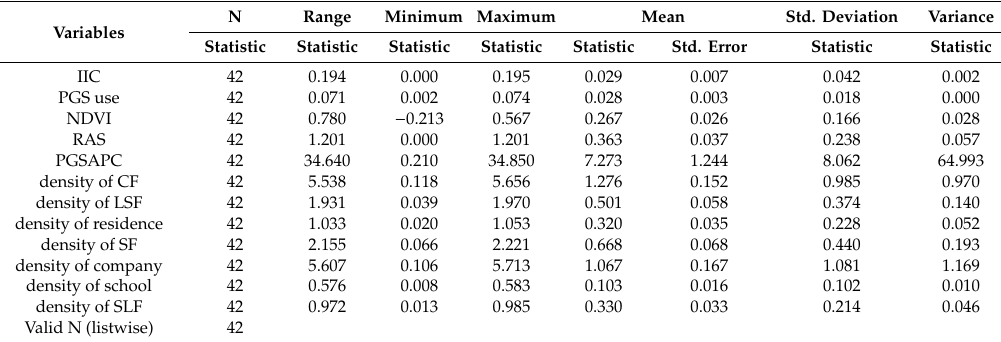
Table 2. Descriptive statistics (before